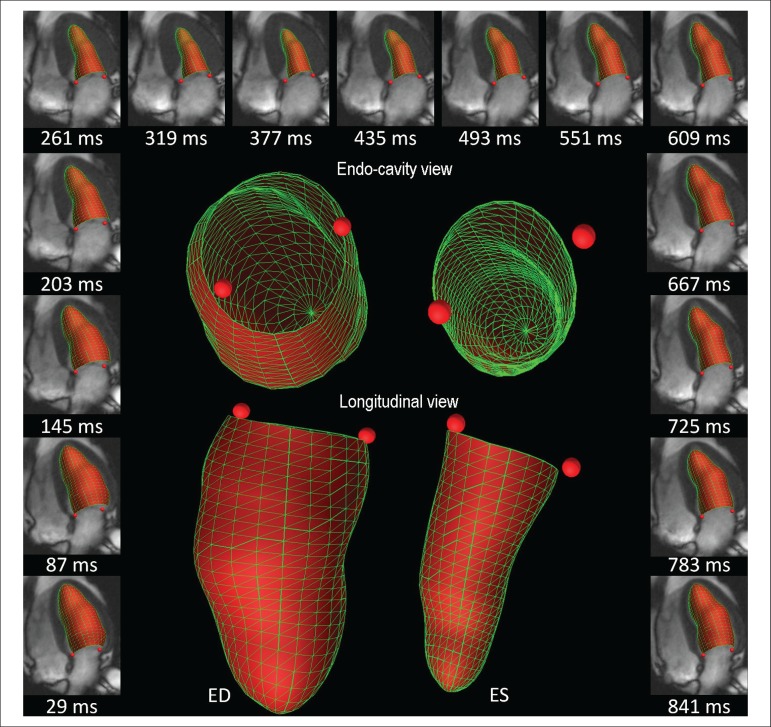
Three-dimensional displays of the model fits throughout the cardiac
cycle in one R-R interval of 870 ms (outside images) for volume- and
derivative-curve assessment (mL/s). Septal and lateral guide points
motion can be evaluated through time, calculating the distance
between the defined point and the model apex for myocardial
longitudinal relaxation rate (mm/s). The endocardial surface is
shaded in red and drawn with green lines.